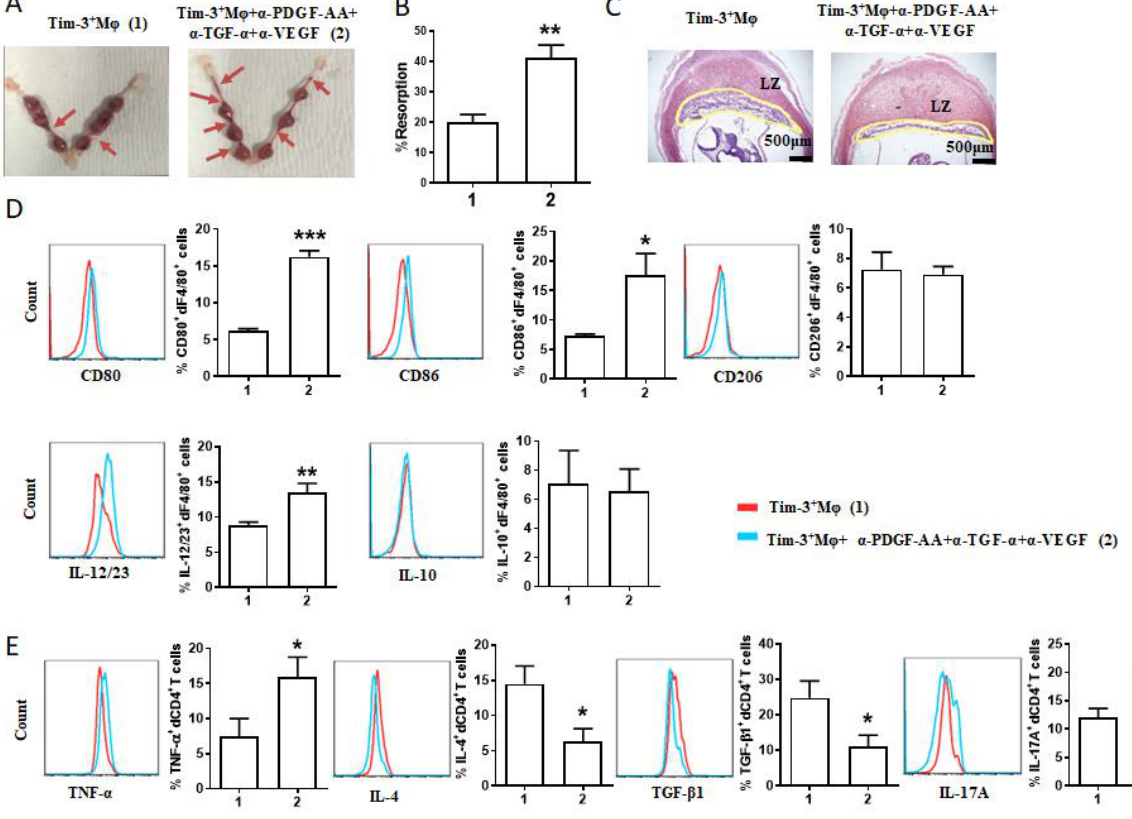
Figure 4. The protective effect of Tim-3 + M ϕ s on murine pregnancy was counteracted by AGF block- ade. ( A – C ) Representative images of uterus ( A ), statistics of the percentage of fetal resorption ( B ), and representative images of placental hemisections (H&E-stained) ( C ) of pregnant mice after M ϕ de- pletion and adoptive transfer of indicated Tim-3 + M ϕ s. Fetal loss sites were identified as necrosis and hemorrhagic spots (shown with red arrows). ( D ) Representative images of flow cytometry and quantifications of surface molecule and cytokine expression of dF4/80 + cells from pregnant mice after M ϕ depletion and the indicated adoptive transfer. ( E ) Cytokine expression of dCD4 + T cells of pregnant mice after M ϕ depletion and the indicated adoptive transfer. Data represent mean ± SEM ( n = 5–11). * p < 0.05, ** p < 0.01, *** p < 0.001, compared with group